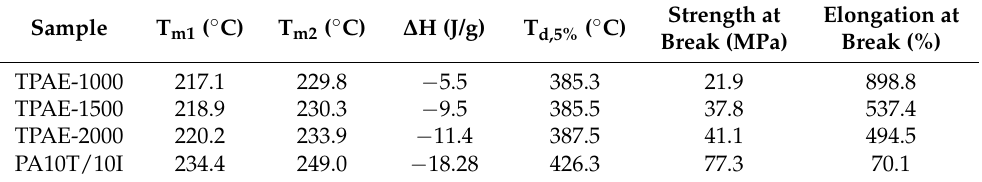
Figure 3. The second heating differential scanning calorimetry (DSC) curves of TPAEs and PA10T/10I at a heating rate of 10 °C min −1 . Table 2. Thermal and mechanical properties of TPAEs and PA10T/10I.